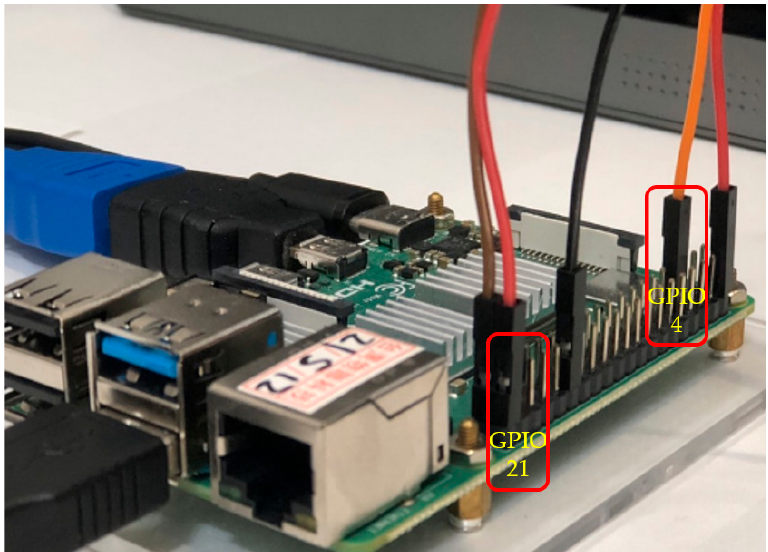
Figure 9. The embedded system and external wiring diagram.